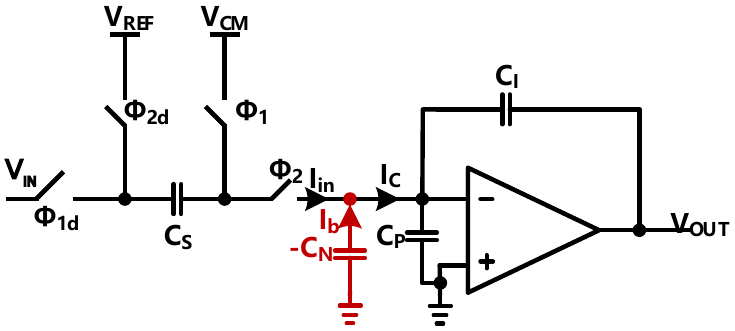
Figure 6. Schematic of the proposed low parasitic capacitance